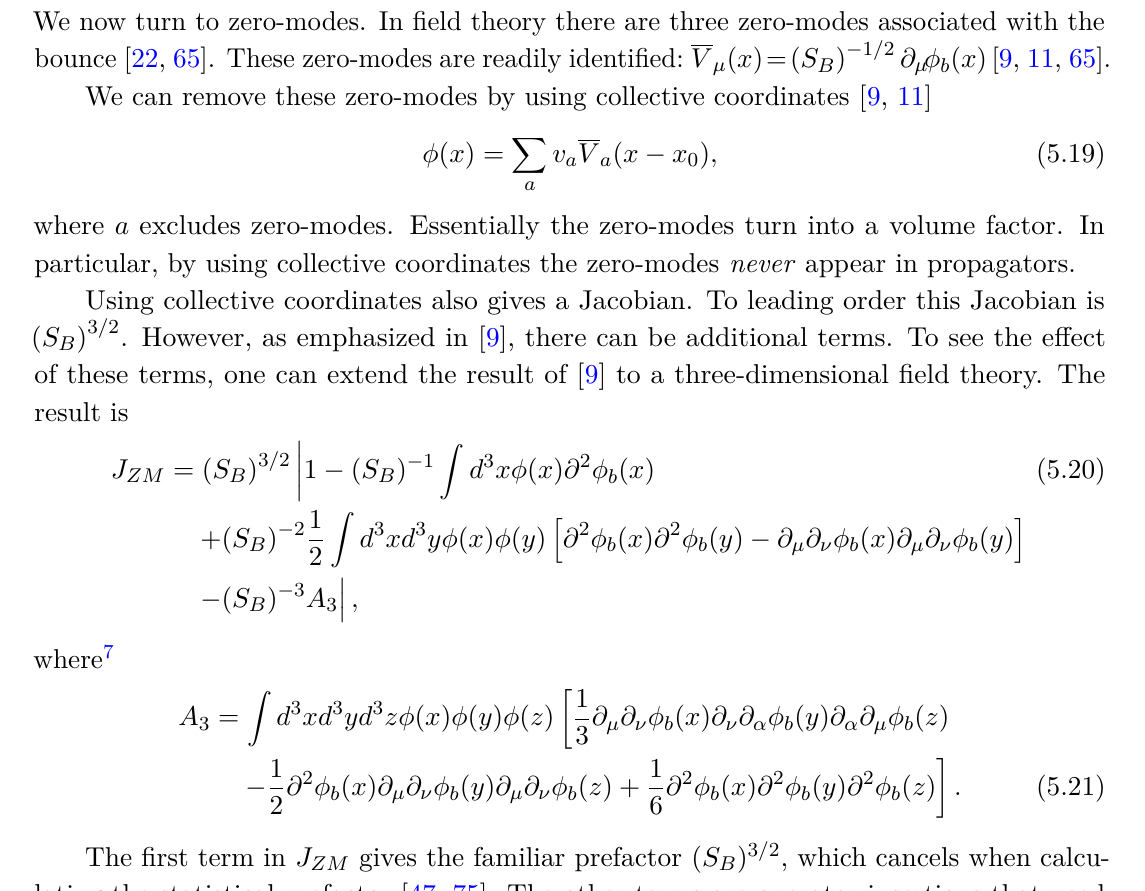
Figure 8 . Diagram contributing to the dynamical